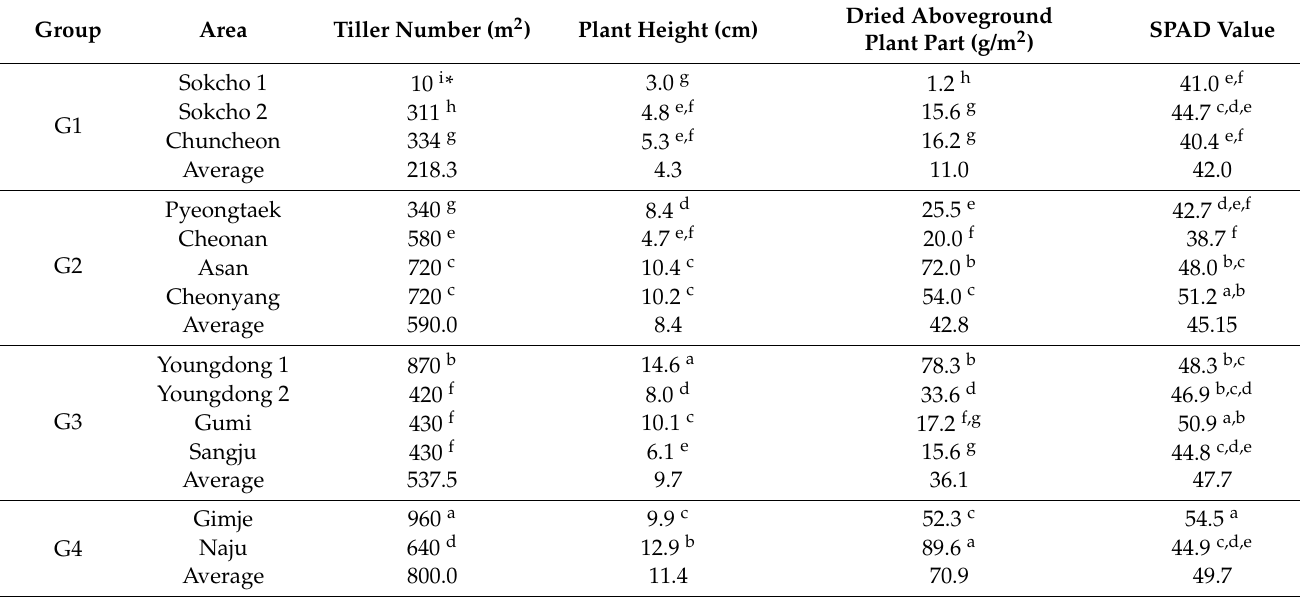
Table 2. Growth and chlorophyll contents (SPAD value) of dehulled barley plants in different group areas after overwintering